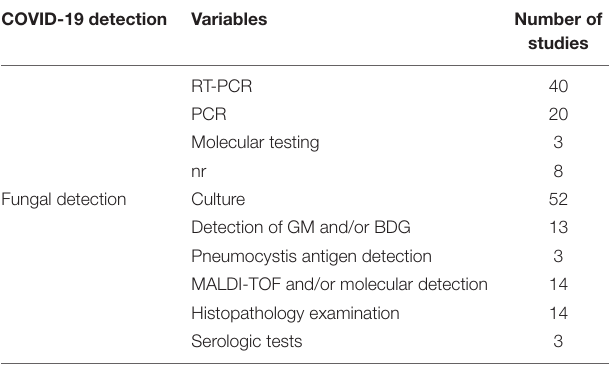
TABLE 4 | Diagnostic methods for patients with COVID-19 and fungal infection. COVID-19 detection